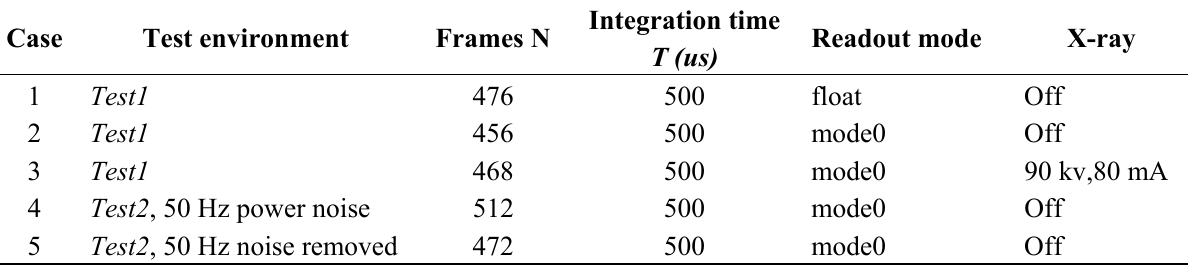
Table 3. Experiment cases of independence test.